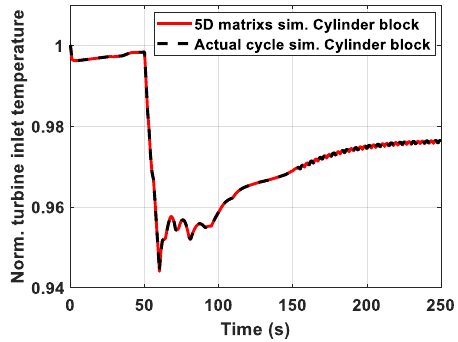
Figure 26. Turbine inlet pressure time history.